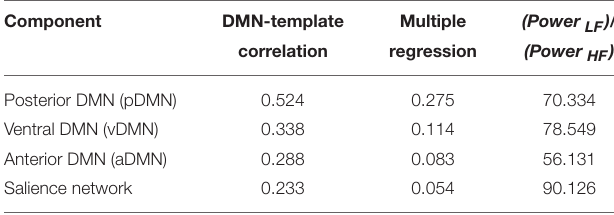
TABLE 2 | Identification of DMN subnetwork components by correlation to the DMN spatial template.